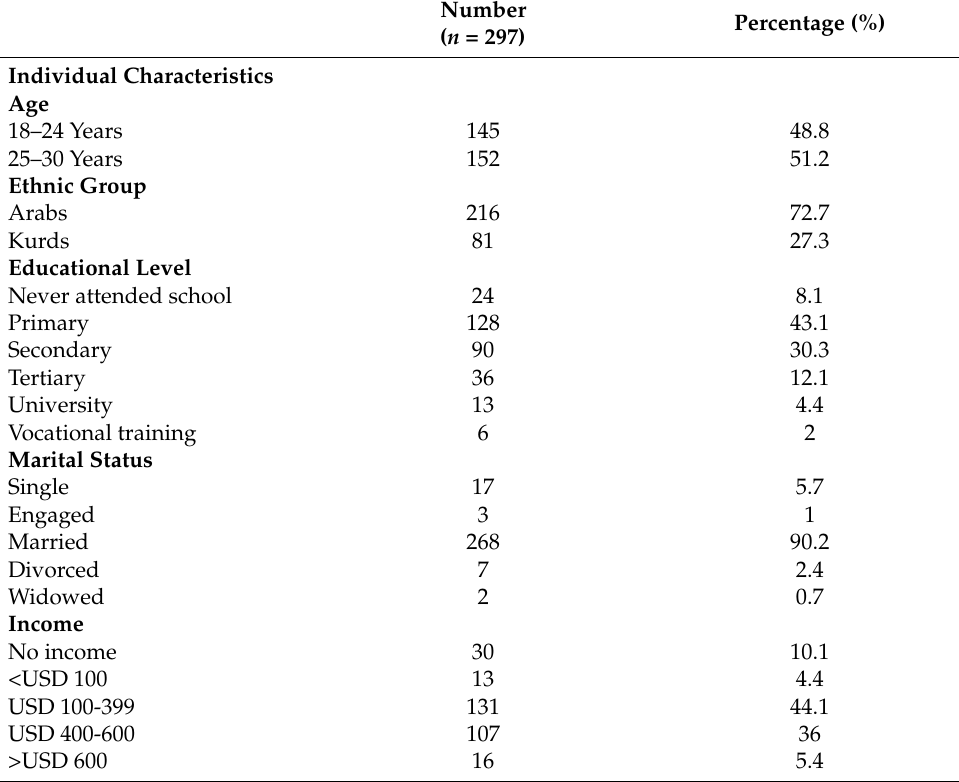
Figure 1. Distribution of participants ( n = 297) by governates of origin in Syria. Table 1. Demographic and Displacement Characteristics of Participants.